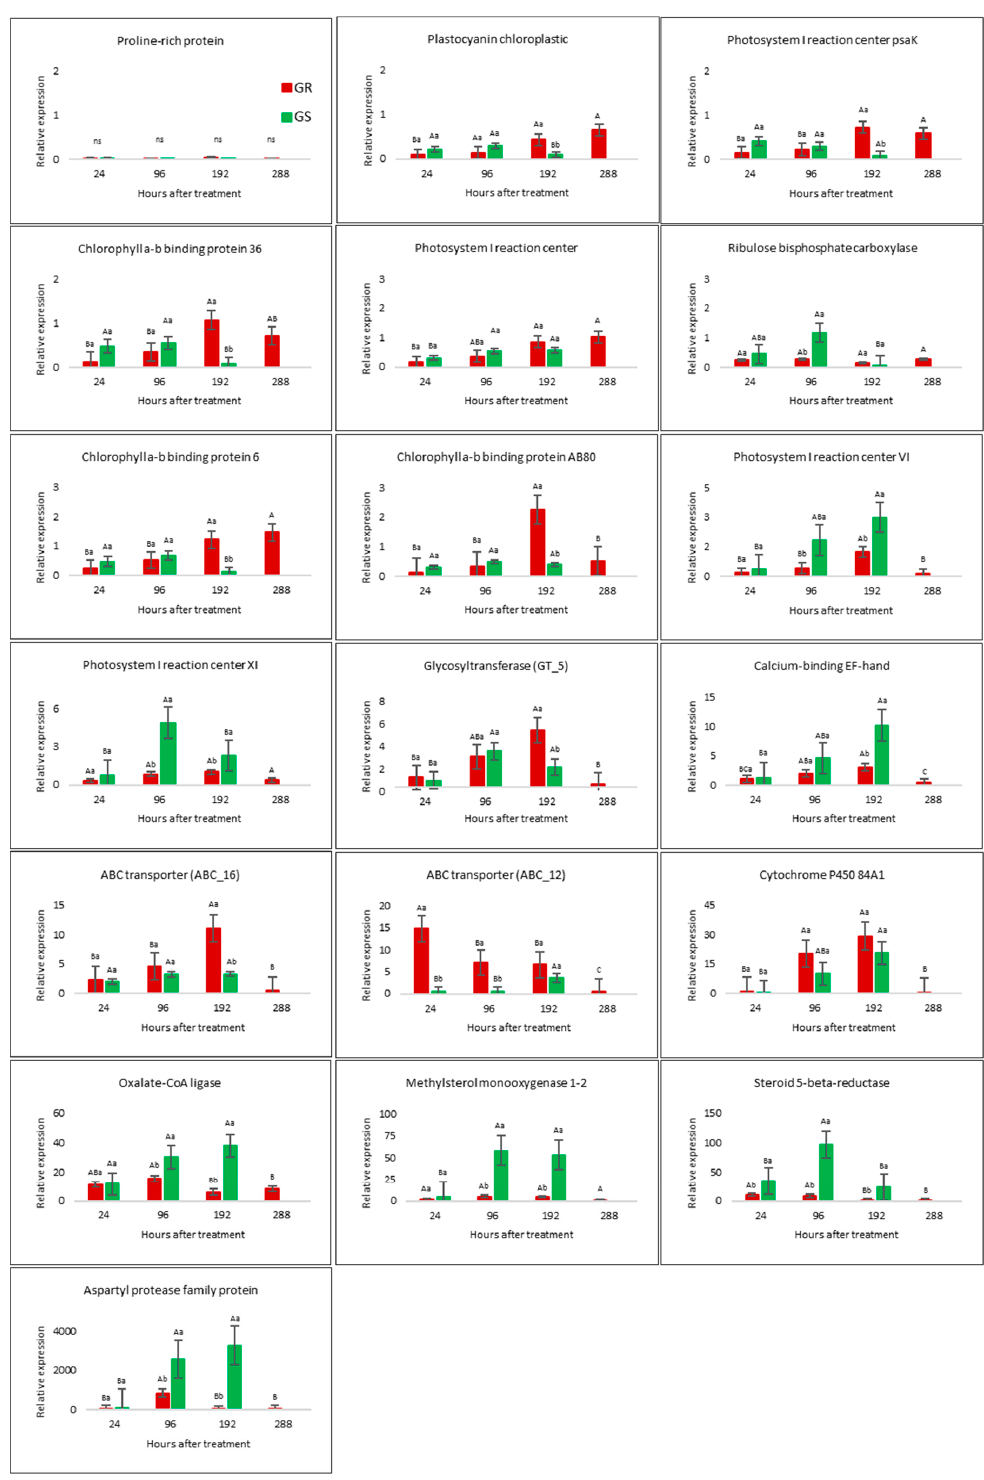
Figure 4. Relative expression levels of 19 selected genes in leaves of C. bonariensis glyphosate-resistant (GR — red bars) and -sensitive (GS — green bars) biotypes in a time-course experiment after glyphosate treatment relative to an internal control hexosyltransferase gene expression in the untreated plants using real-time RT-PCR (2 − △△ Ct ). Results were compared by contrasts (p ≤ 0.05), and upper-case letters indicate comparisons of each biotype in di ff erent times and lower-case letters between biotypes in each respective